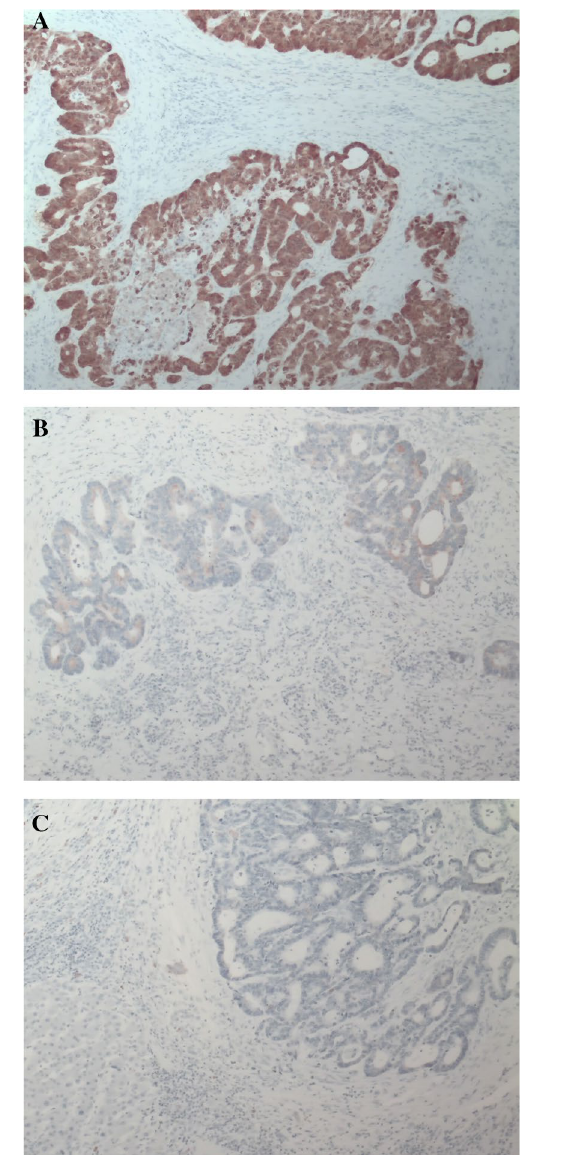
Fig. 5 A – C Immunohistochemical analysis revealed that the tumor was positive for caudal-type homeobox protein 2 and negative for CK7 and CK20. (Staining, ×